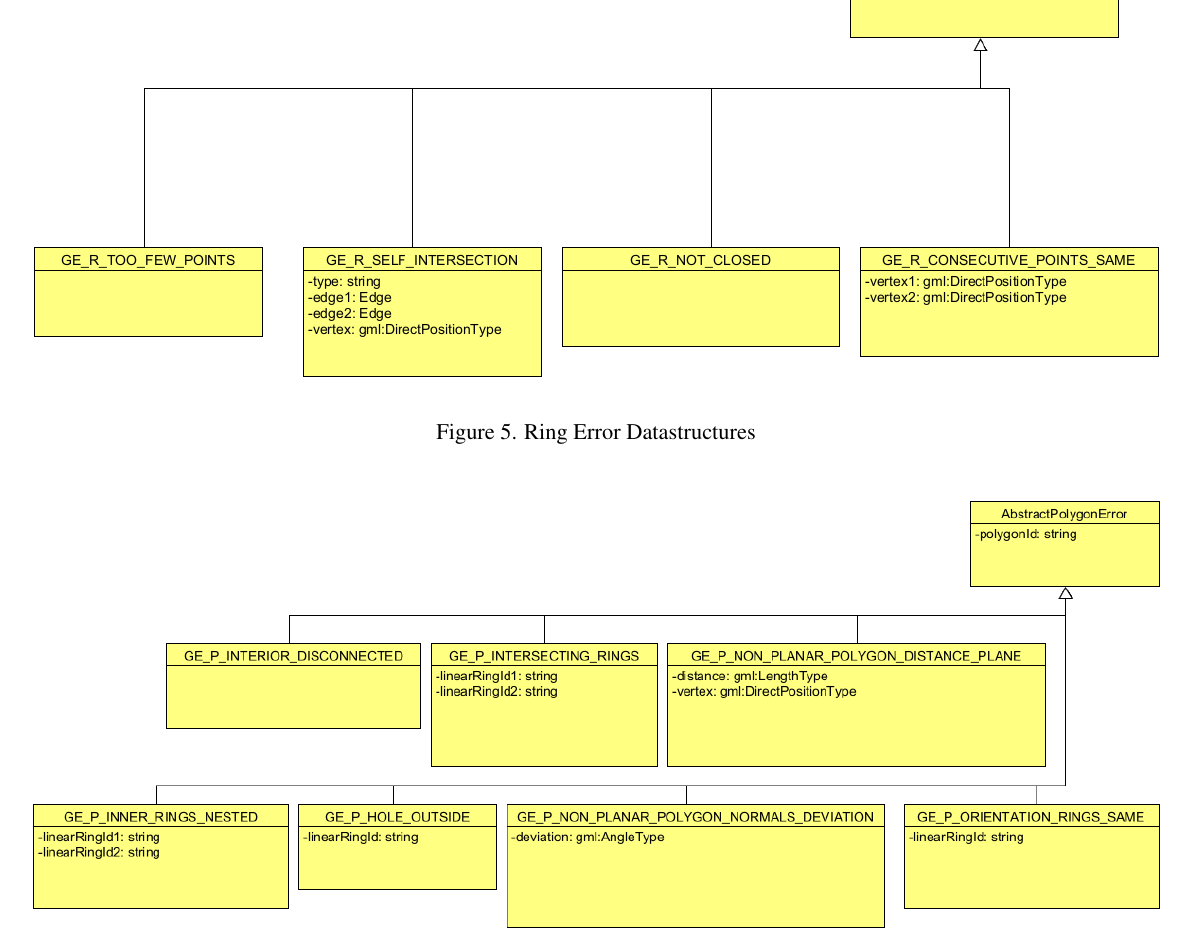
Figure 6. Polygon Error